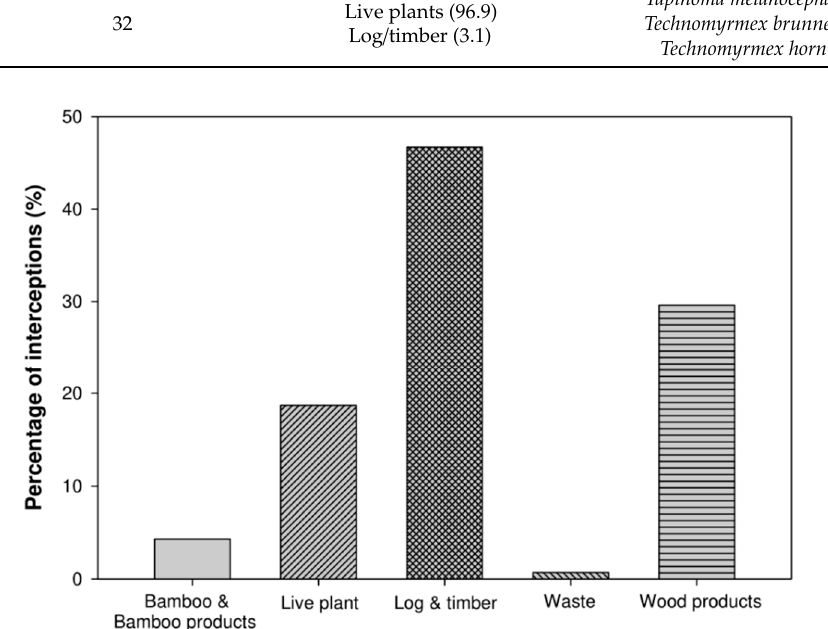
Figure 1. Type of commodity with which intercepted ants were associated from 2011 to 2018.